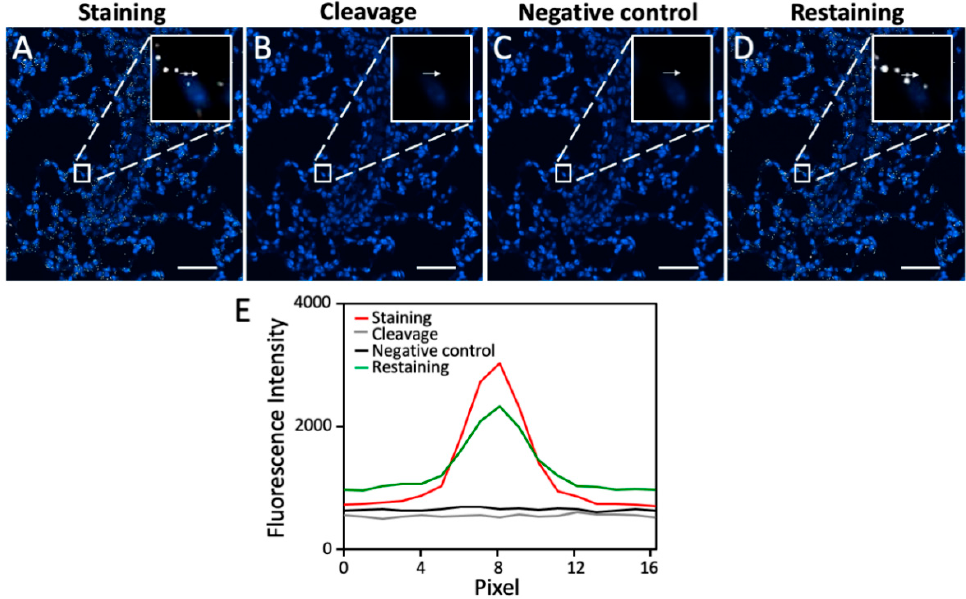
Figure 2. ( A ) mRNA PPIB in FFPE mouse lung tissue is hybridized with the target recognition and signal amplification probes and then stained with tyramide-N 3 -Cy5. ( B ) The fluorophore is cleaved by TCEP at 40 °C for 30 min. ( C ) After probe stripping with 1 h DNase treatment at room tempera- ture and 30 min 70% formamide treatment at 40 °C, the tissue is incubated with the signal amplifi- cation probes and tyramide-N 3 -Cy5, in the absence of the target recognition probes. ( D ) After 12 h of TCEP treatment at 40 °C, 24 h of DNase treatment at room temperature, and 12 h of 70% forma- mide treatment at 40 °C, mRNA PPIB in the same FFPE mouse lung tissue is rehybridized with the target recognition and signal amplification probes and then stained with tyramide-N 3 -Cy5. ( E ) Flu- orescence signal intensity corresponding to the arrow positions in ( A – D ). Scale bar, 50